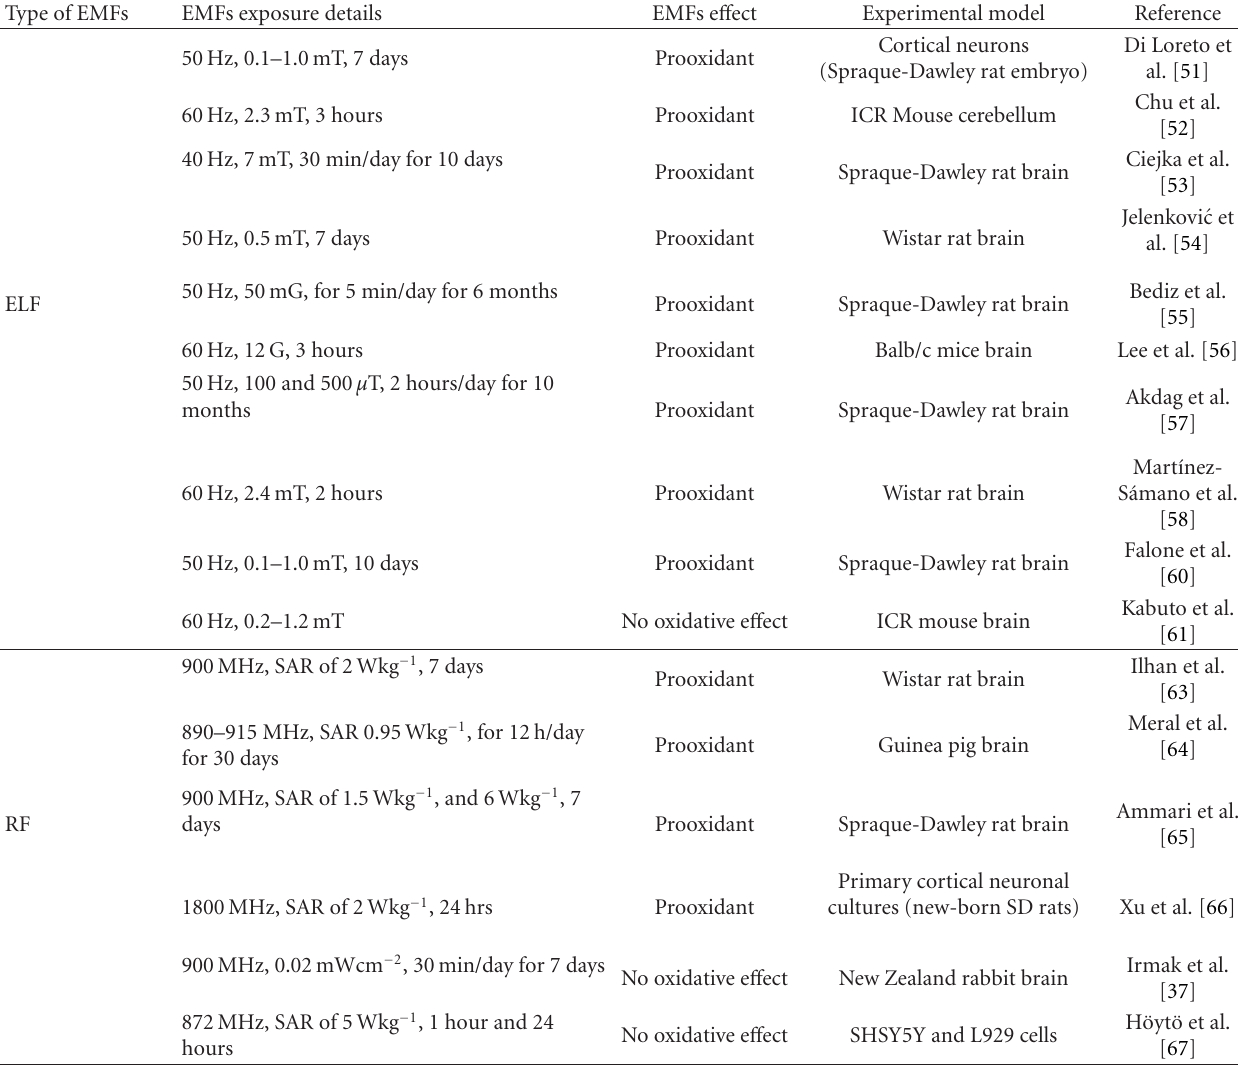
Table 1: EMFs exposure and oxidative stress in